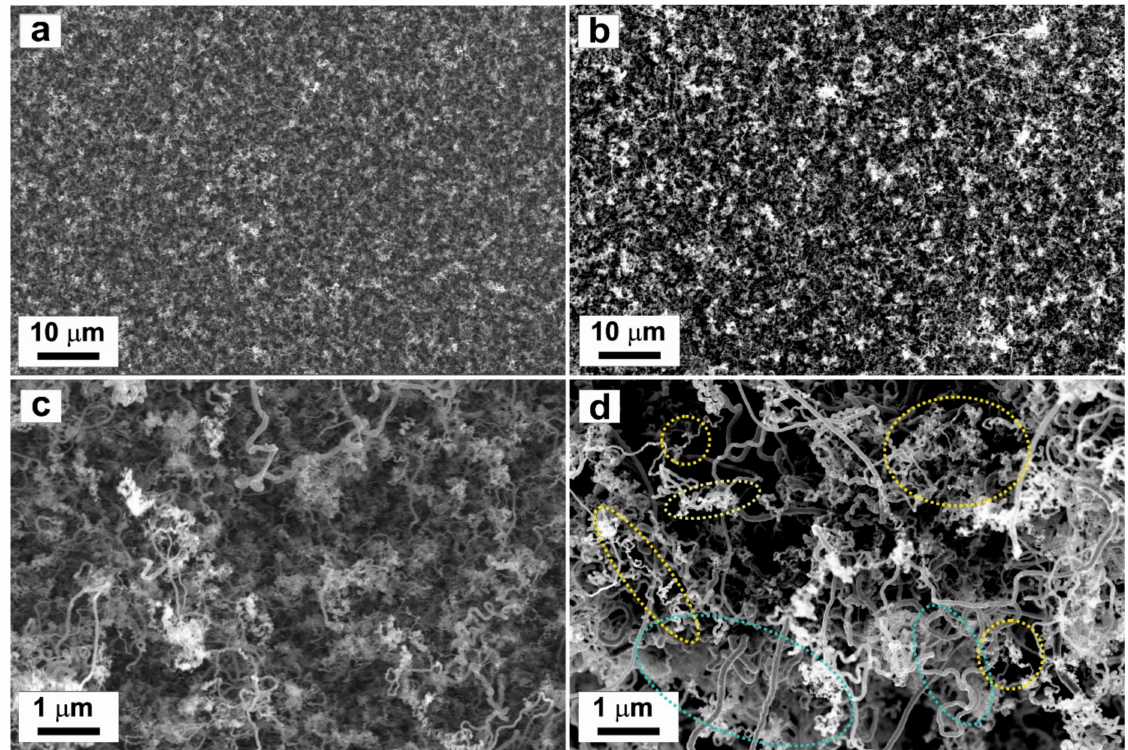
Figure 4. High-resolution SEM images of ( a , c ) graphene/ f -MWCNT nanocomposite and ( b , d ) graphene/ f -MWCNT nanocomposite decorated with PdMg alloy nanoparticles deposited on Pt substrate. Yellow ovals highlight the decorative clusters of PdMg